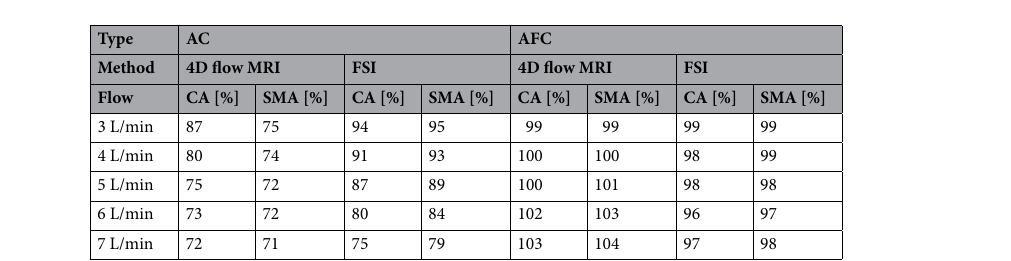
Table 4. Normalized area of the true lumen at the CA and SMA levels in AC and AFC 22 . AC axillary cannulation, AFC axillary and femoral cannulation, CA celiac artery, FSI fluid–structure interaction, 4D flow MRI four-dimensional flow magnetic resonance imaging, SMA superior mesenteric